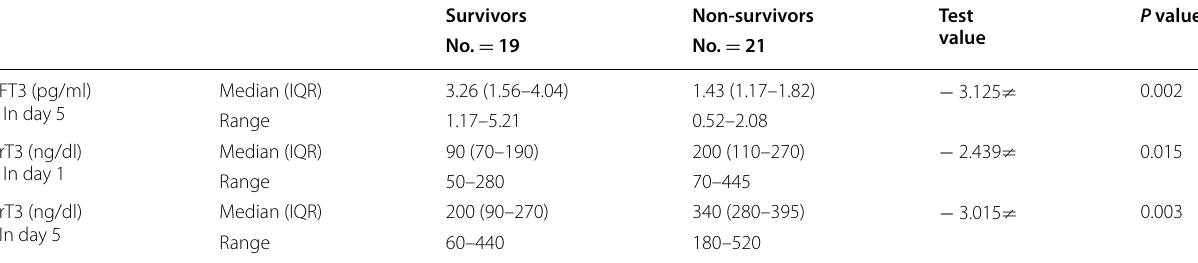
The patients were followed up until discharge or death and based on the outcome, they were divided into two groups: survivors (included 19 patients) and non-survi- vors (included 21 patients). NTIS was found to be more prevalent among non-survivors compared to survivors (61.9% versus 31.6%); however, the values did not reach level of significance (Table 5).